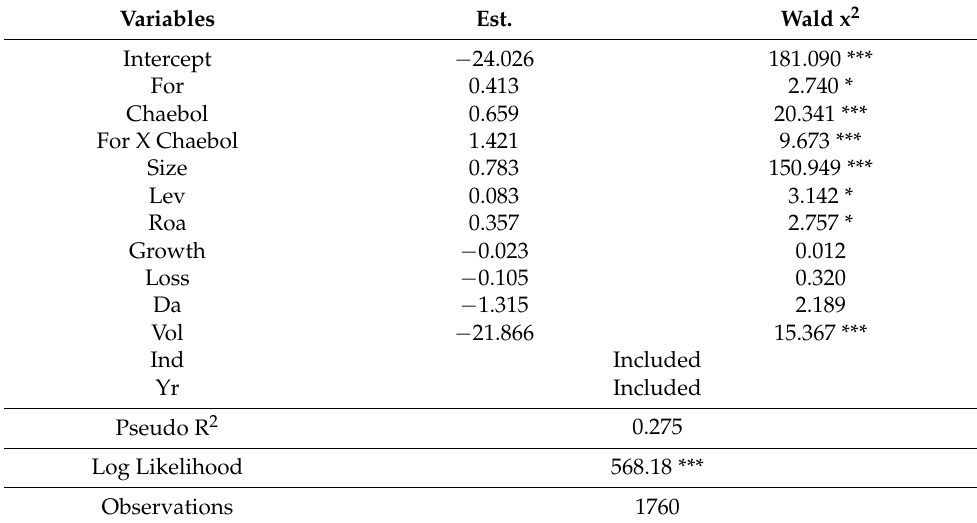
Table 7. The effect of Chaebol-affiliated firms on the relationship between foreign investors and voluntary